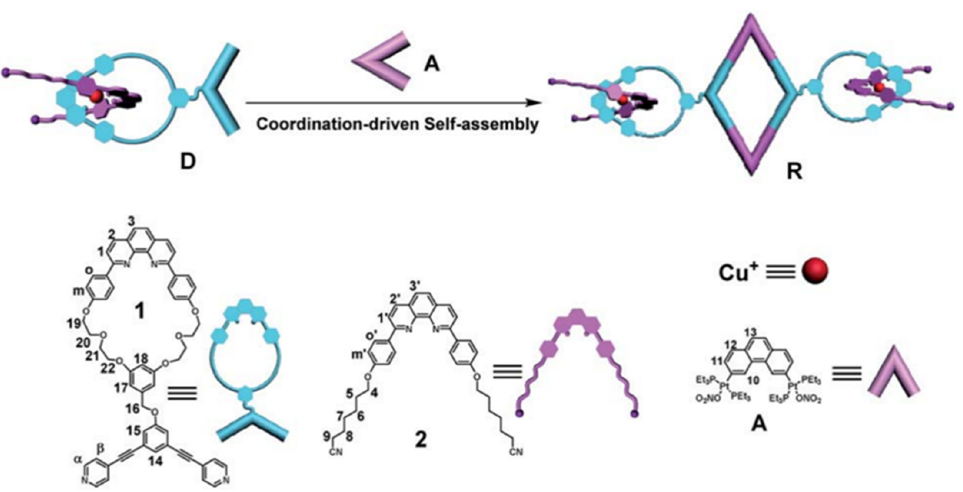
Figure 37. Illustration of the self-assembly bis-[2]pseudorotaxanes rhombohedral metallacycle (re- produced with permission of the Royal Society of Chemistry from ref. [122]).